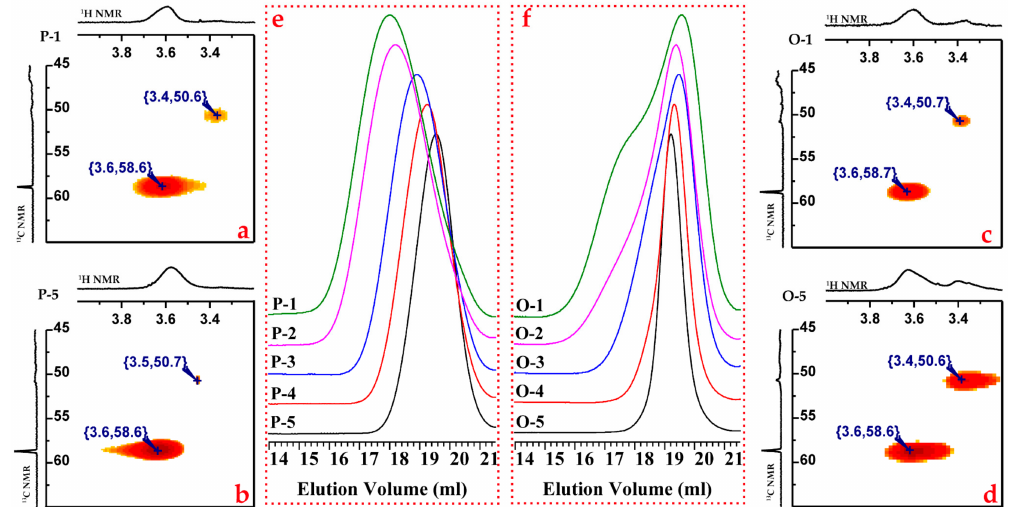
Figure 9. ( a – d ) The 1 H- 13 C HMBC 2D NMR spectra of P-1, P-5, O-1, and O-5, respectively. ( e , f ) The SEC chromatograms of P-1 and P-5.